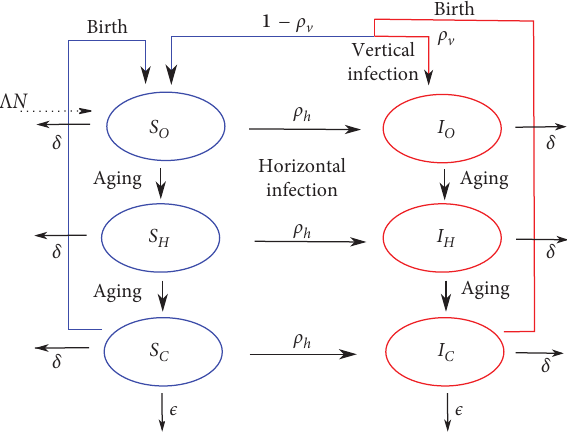
Figure 1: The flow diagram describing the dynamics of N. caninum infection in dairy cattle (dashed line: the varied buying or selling rate Λ into the S O compartment). Subscripts O , H , and C represent offspring, heifers, and cows,